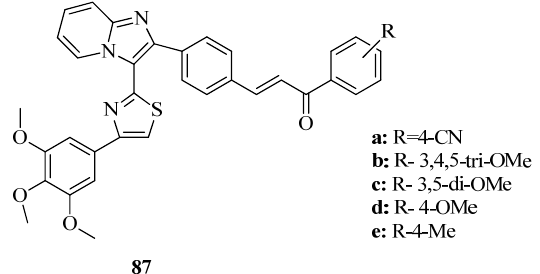
Figure 34. Structures of chalcone-linked thiazole-imidazopyridine derivatives.